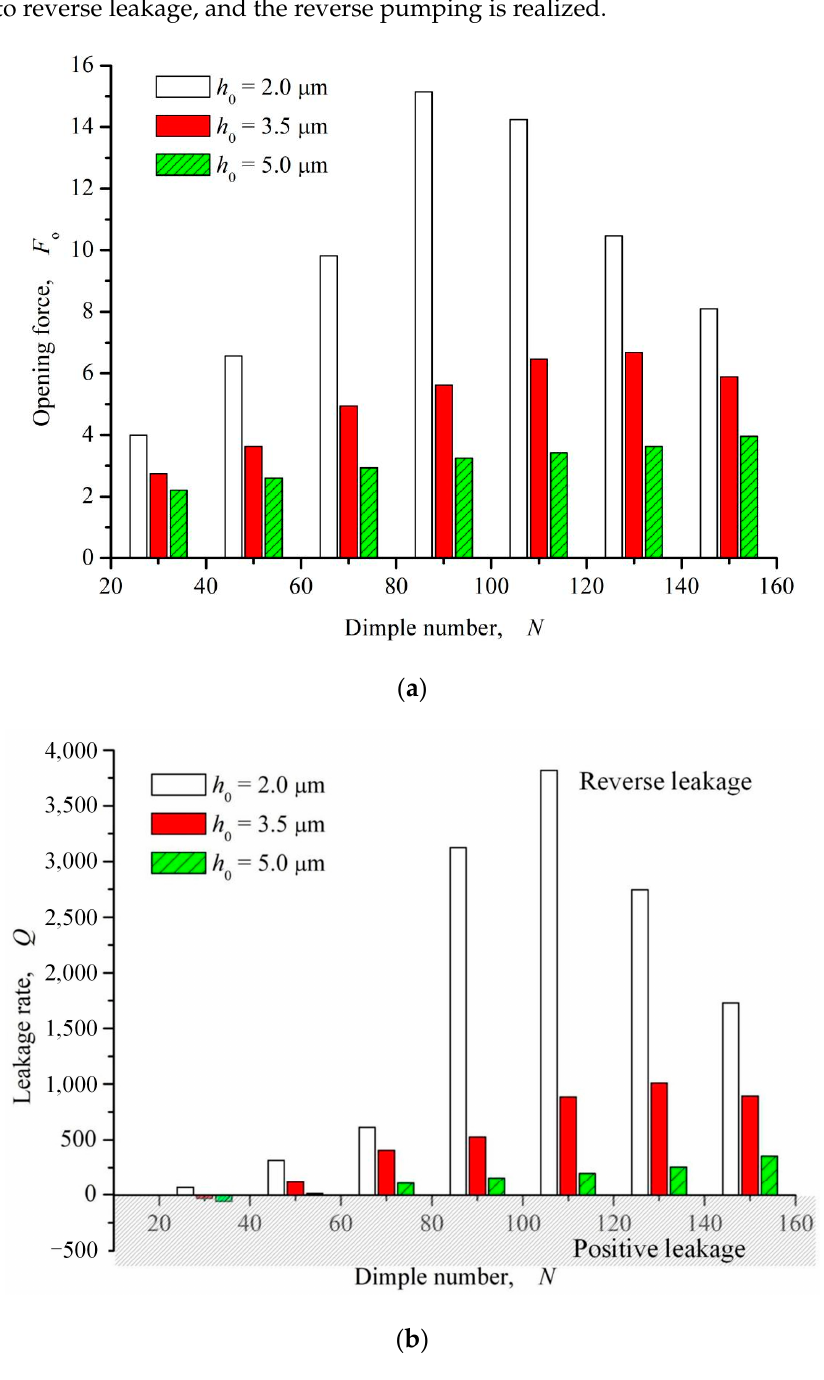
Figure 11. In fl uence of dimple number on opening force and leakage rate ( ω = 12,000 rpm, P o = 4, h 0 = 2 μ m, γ = 3, α = 45°). ( a ) Opening force; ( b ) Leakage